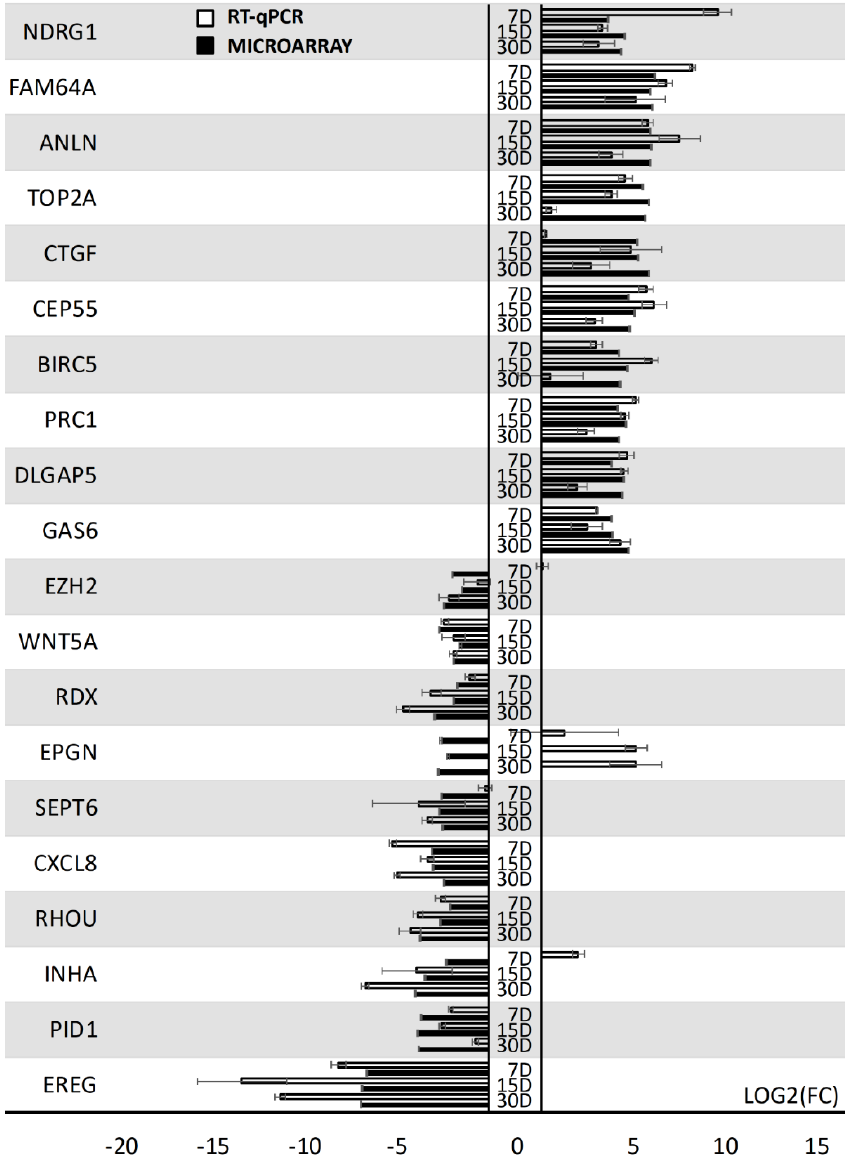
Figure 5. The results of the RT-qPCR validation of expression microarrays (log (FC)), presented as a bar graph. Error bars represent the standard error of the mean (SEM; n = 3). All of the presented sample means were deemed to be statistically significant ( p < 0.05). D: day of culture; FC: fold change.